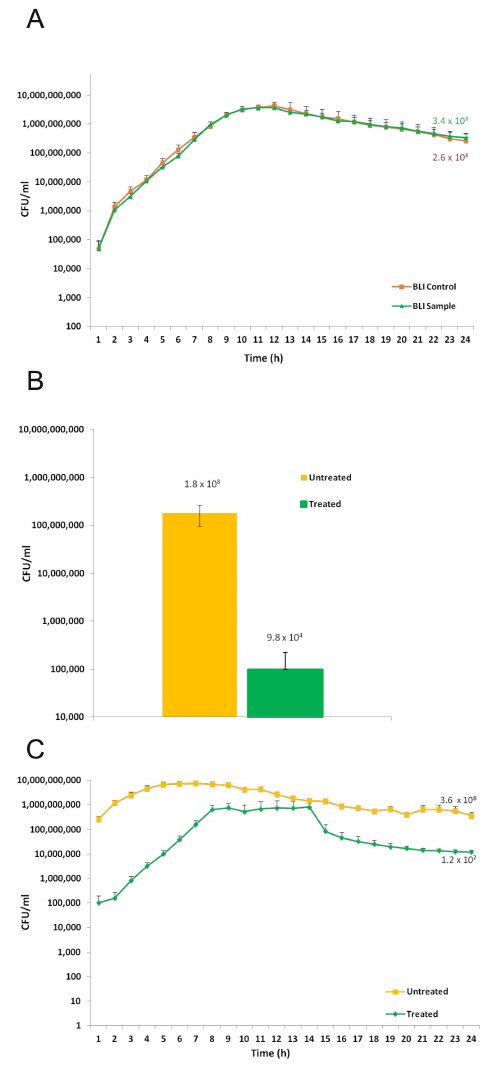
Figure 6. P. aeruginosa growth and biofilm formation on titanium disks, treated or not with Bic40 procedure, as assessed by a bioluminescent (BLI) bacterial strain. ( A ) P. aeruginosa growth was not affected by the presence of titanium disks. BLI- Pseudomonas (10 6 / mL) in TSB plus 2% sucrose was seeded in 96 black well-plate and incubated at 35 ◦ C in the presence (orange) or absence (green) of titanium disks (1 / well). The plates were then incubated by Fluoroskan and the bioluminescent signal was recorded in real time (h), up to 24 h. By the calibration curve, the RLUs were converted in CFU / mL + SEM (Standard Error Mean), as indicated in the Y axis. ( B ) Effects of the cleaning procedure on titanium disks-associated biofilm. Microbial biofilm produced onto titanium disks (by 24 h incubation, as above) was exposed or not to the Bic40 cleaning procedure (treated vs. untreated group); the residual bioluminescent signal was measured and converted, by the calibration curve, in CFU / mL ± SEM, as indicated in the Y axis. ( C ) Real time monitoring of P. aeruginosa re-growth on treated and untreated titanium disks. The microbial re-growth, occurring in Bic40-treated and untreated disks, was evaluated in real time, for additional 24 h. Then, the bioluminescent signal was measured and converted in CFU, returning values of 3.6 × 10 8 / mL and 1.2 × 10 7 / mL, in untreated and treated groups,